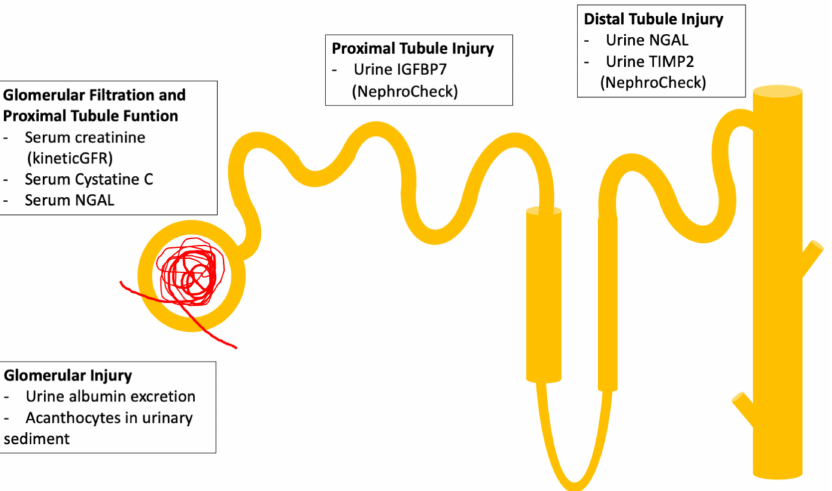
Figure 1. Schematic representation of different biomarkers of AKI which were selected and tested in our study in relation of sites of injury in the nephron. NGAL, neutrophil gelatinase- associated lipocalin; IGFBP7, insulin-like growth factor binding protein 7; TIMP2, tissue inhibitor of